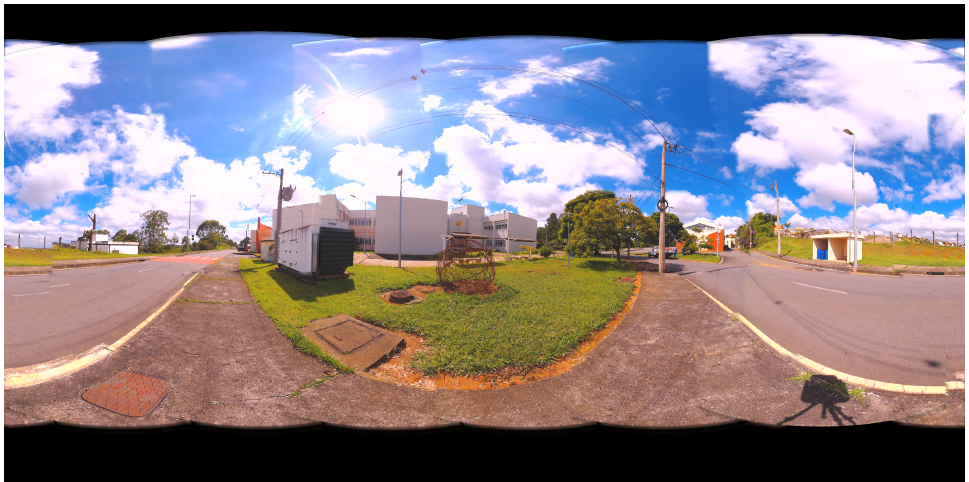
Figure 10. 360 Panoramic Image Resulting from the best method for Case Study I: Particle Swarm Optimization